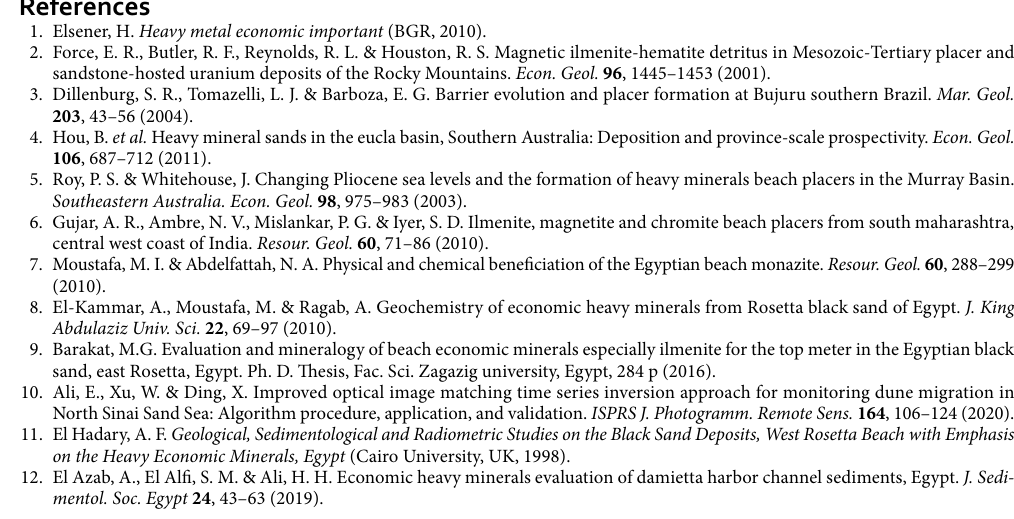
Table 9. The tonnage of individual economic mineral in the studied area.